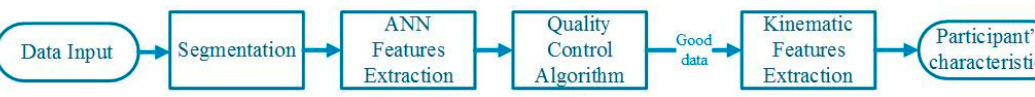
Figure 1. Joint orientation estimates quality control process overview.